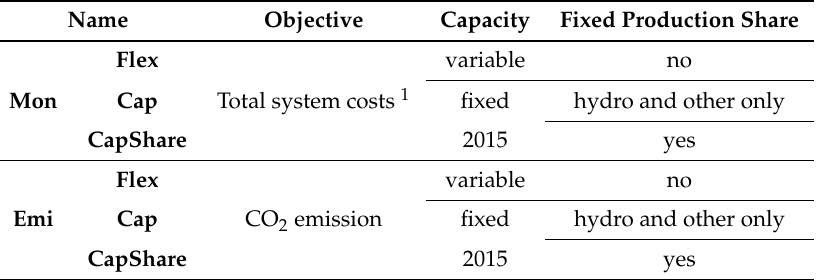
Table 2. Overview of scenarios.